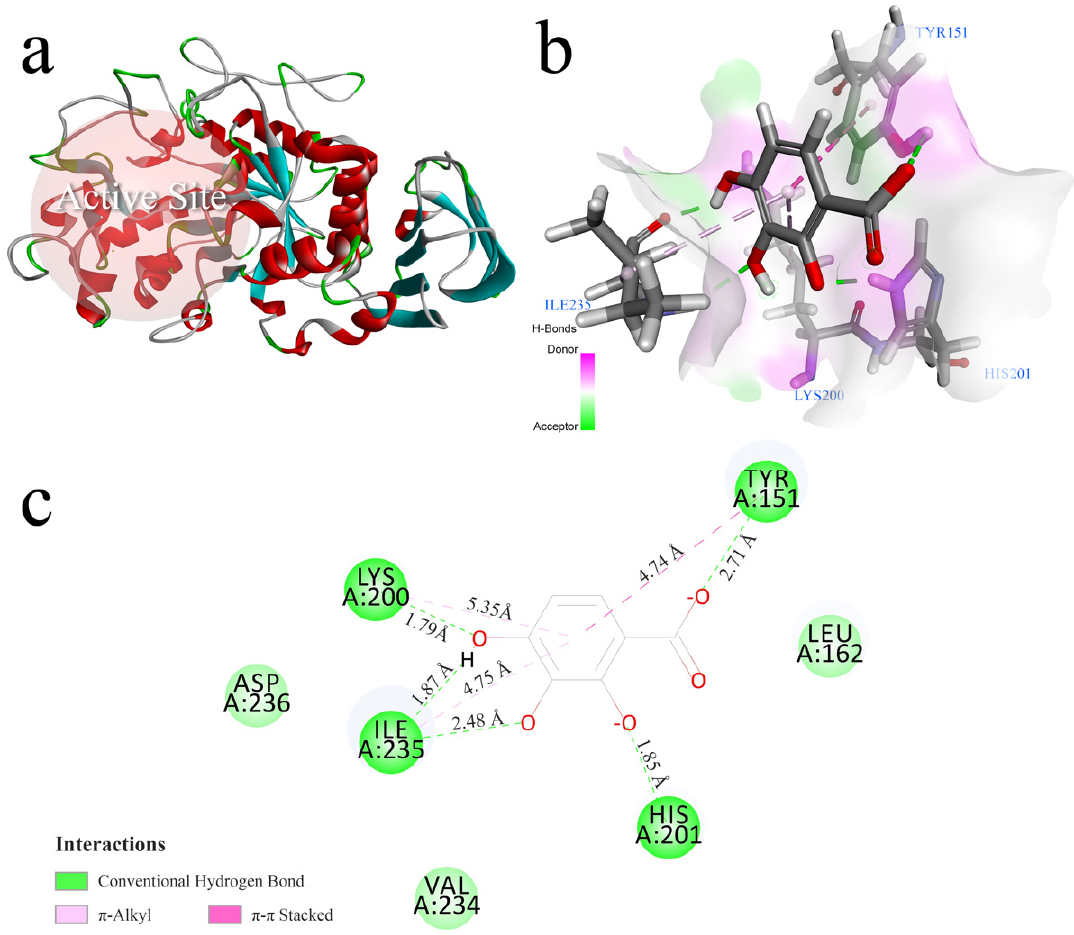
Figure 5. ( a ) The α -amylase crystal structure (4W93) and docking site (also the active site). The molecular docking results of 2,3,4-trihydroxybenzoic acid with α -amylase: ( b ) the best docking pose of 2,3,4-trihydroxybenzoic acid in 4W93, and ( c ) the binding mode of 2,3,4-trihydroxybenzoic acid with 4W93.